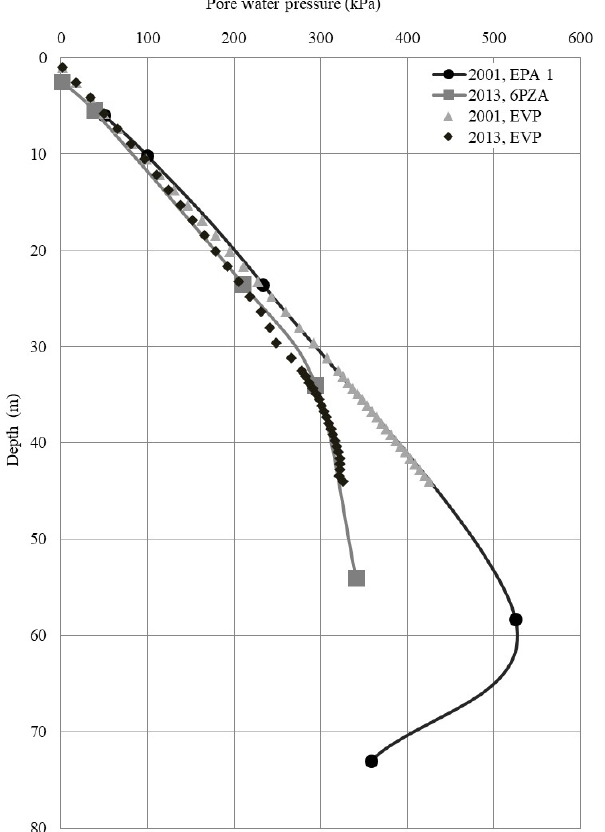
Figure 3. Geotechnical and piezometric conditions. Table 1. Geotechnical properties at the 7Pi site.